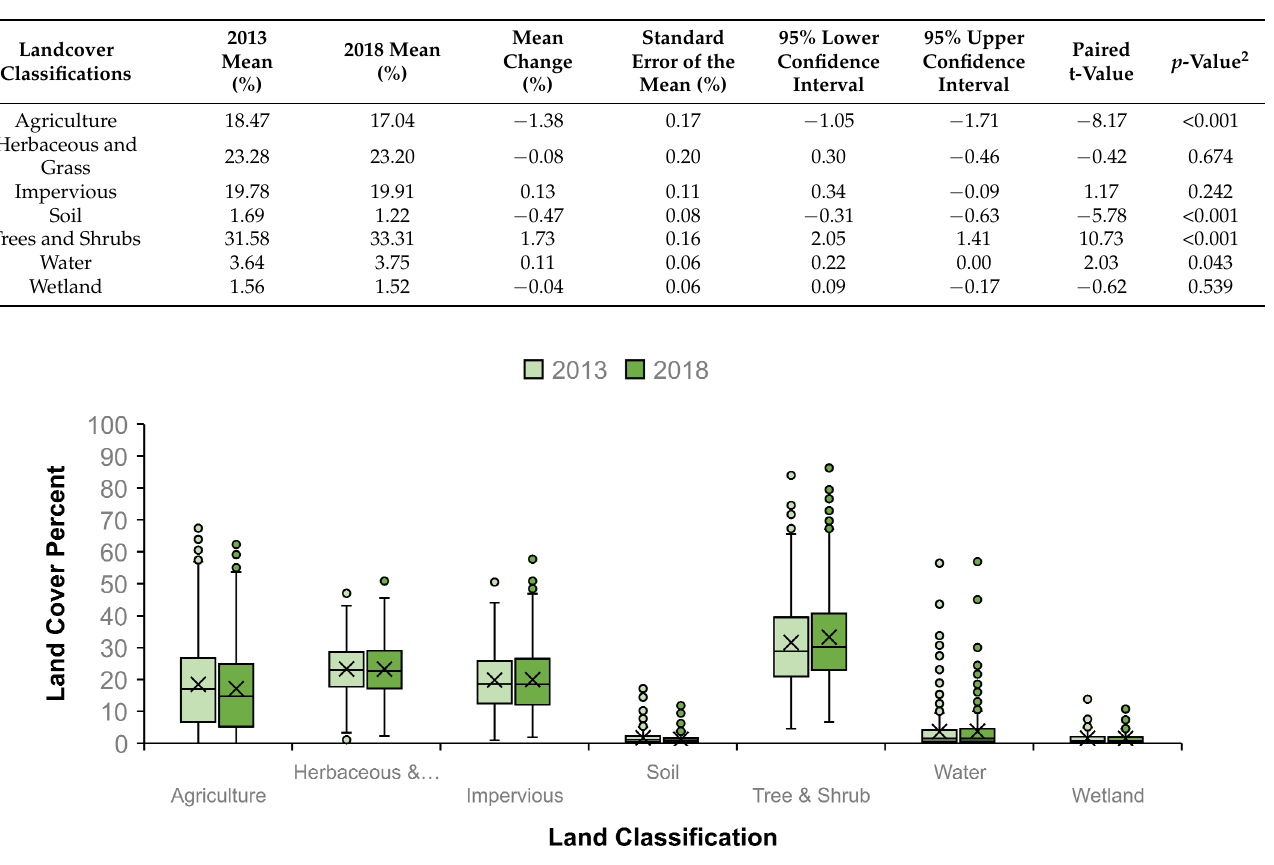
Figure 4. Landcover classification box plot comparison between 2013 and 2018 in Wisconsin, USA. (n = 404). Box plots parts are lower box 1st quartile, line median, X mean, upper box 3rd quartile, line ends are minimum and maximum values, and circles are outliers.